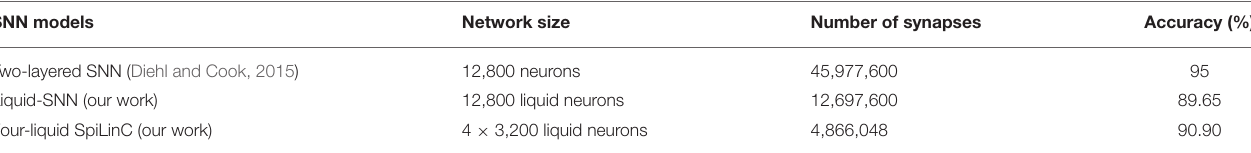
TABLE 7 | Classification accuracy of different SNN models trained using unsupervised STDP on the MNIST